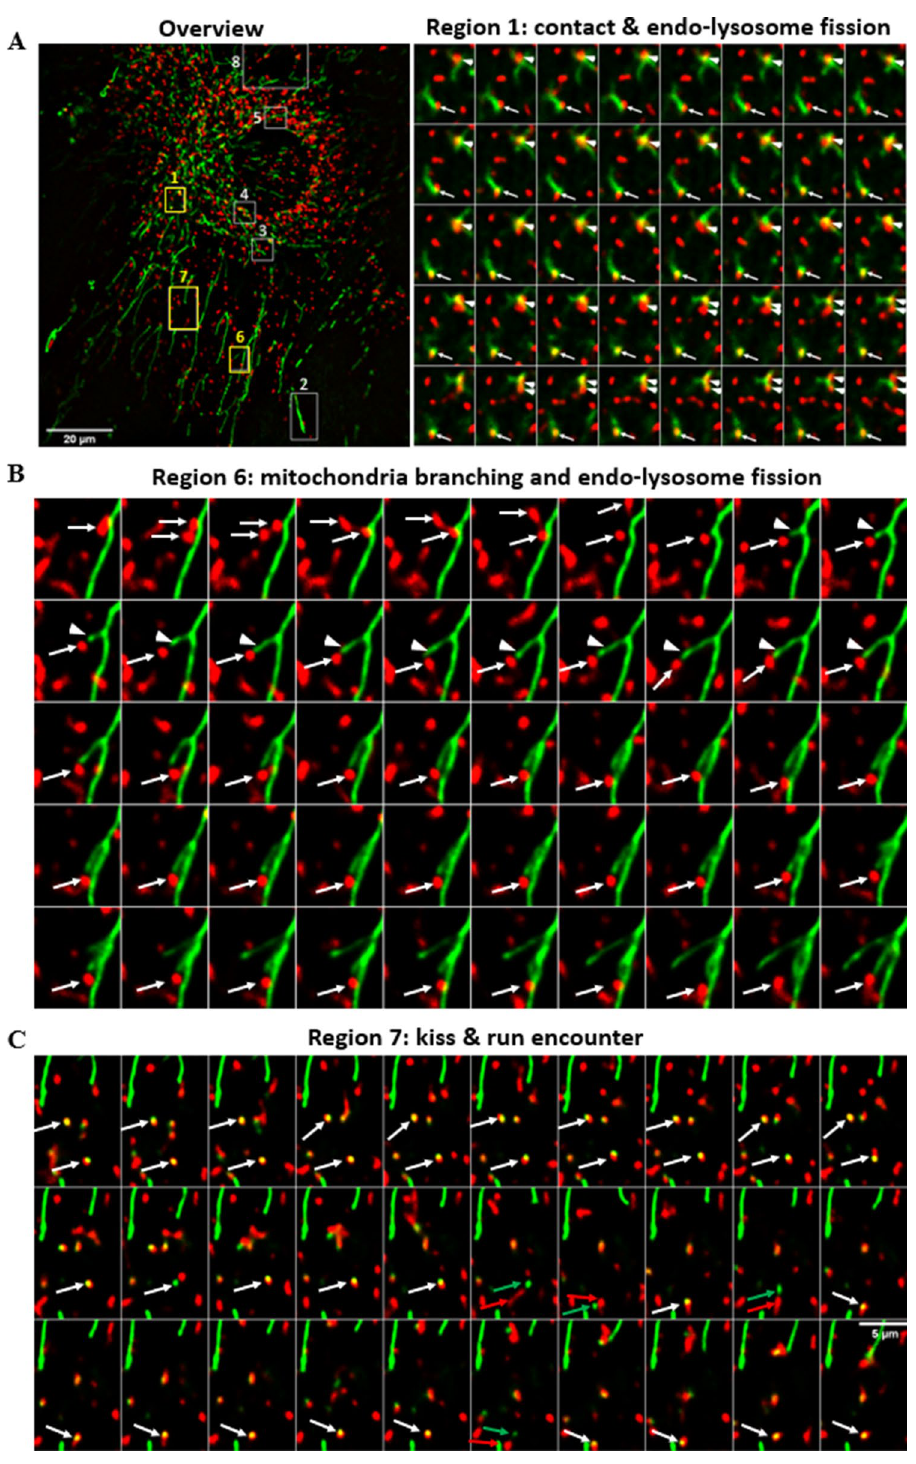
Figure 7. Dynamics of contact formation between endo-lysosomes and mitochondria. NPC2−/− fibroblasts were incubated with 100 nM Alexa546-NPC2 for 72 h and labeled for 30 min with MitoTracker Green before imaging at a spinning disk confocal microscope. Images were acquired every 1 s for 3 min, while cells were kept at 37 °C, 5% CO 2 . A, first frame of whole field with zoomed regions indicated. Only regions 1, 6 and 7 (yellow boxes) are shown in the right panel of A , in B and C , respectively. These and the other boxes are shown as Supplemental videos. Bar, 20 µm. The montage of region 1 shows every second image (i.e. every 2 s), while the montages of region 6 and 7 show every third image (i.e. every 3